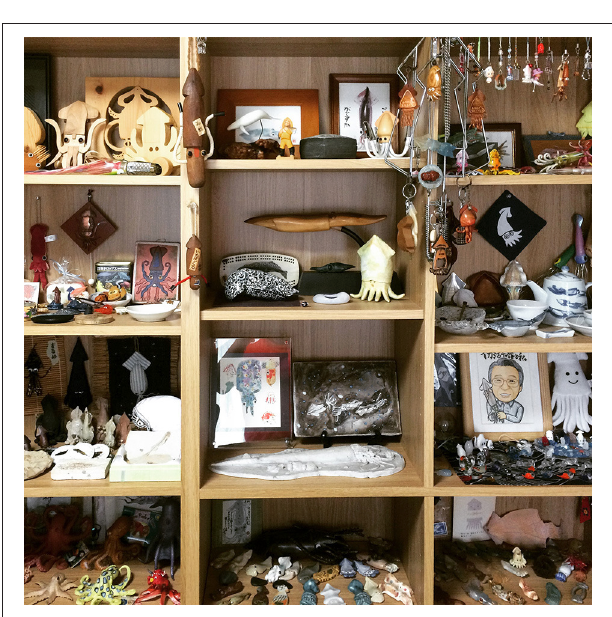
FIGURE 8 | A part of cephalopod figure collection of Dr. Yasunori Sakurai at his home office showing incredible variations in cephalopod character designs (photographs by R.